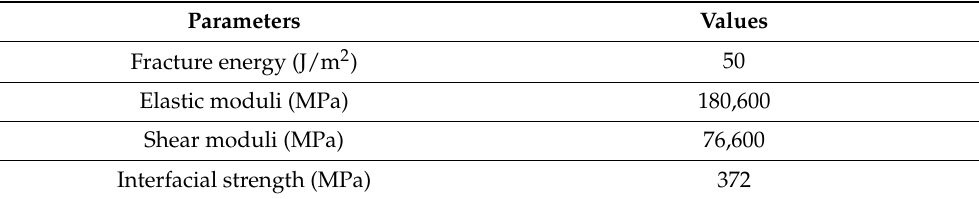
Table 4. Specific parameters of interface